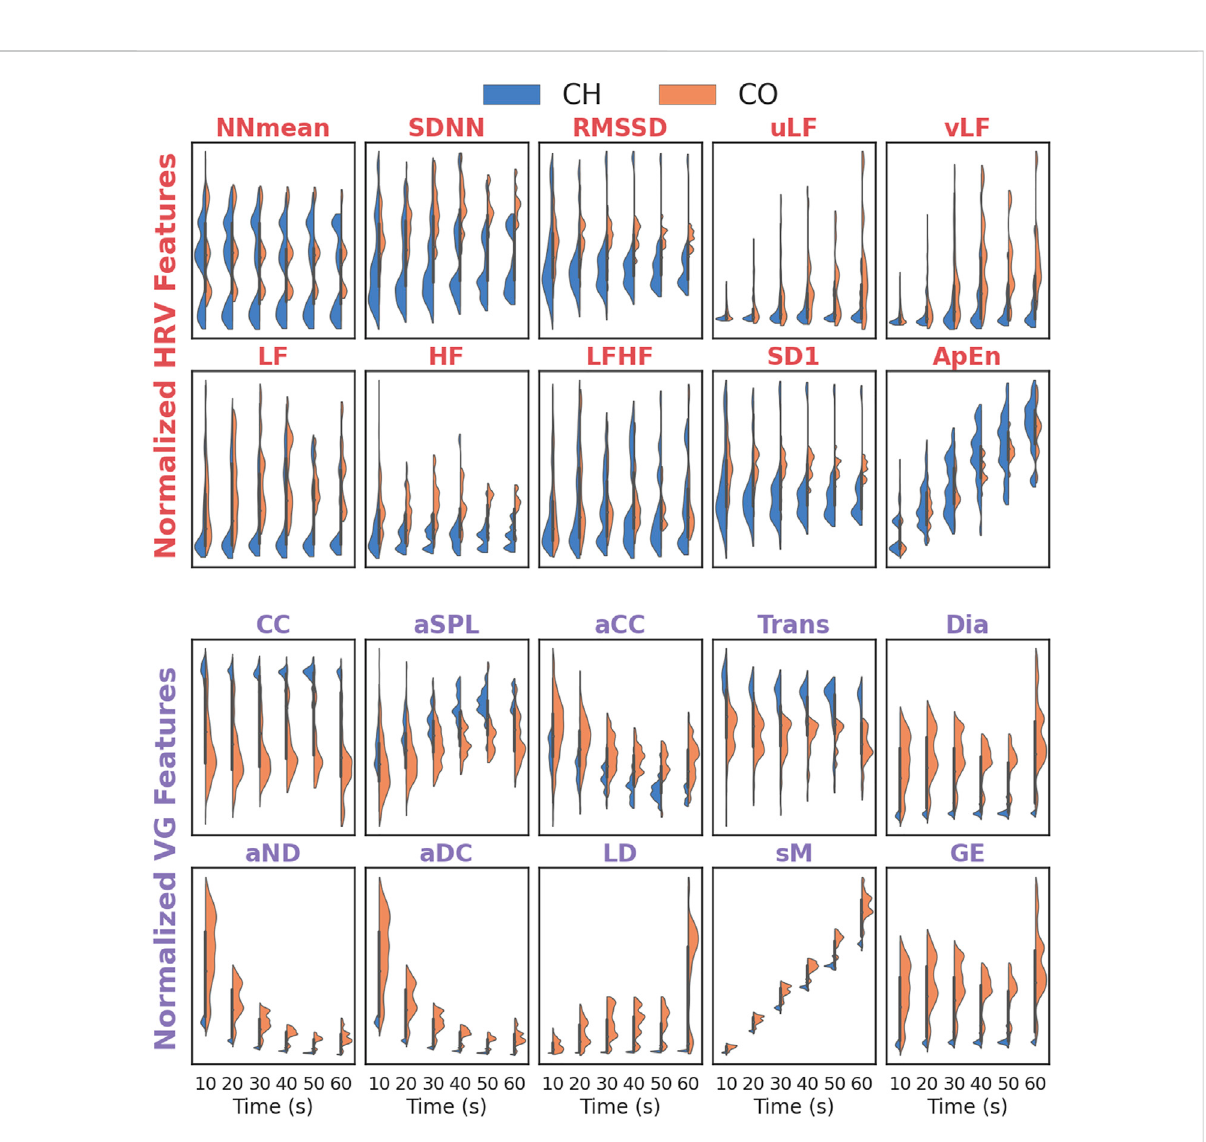
FIGURE 4 The distribution of features (HRV and VG) for different data length. Effectiveness of HRV and VG on ANS-Load Determination.